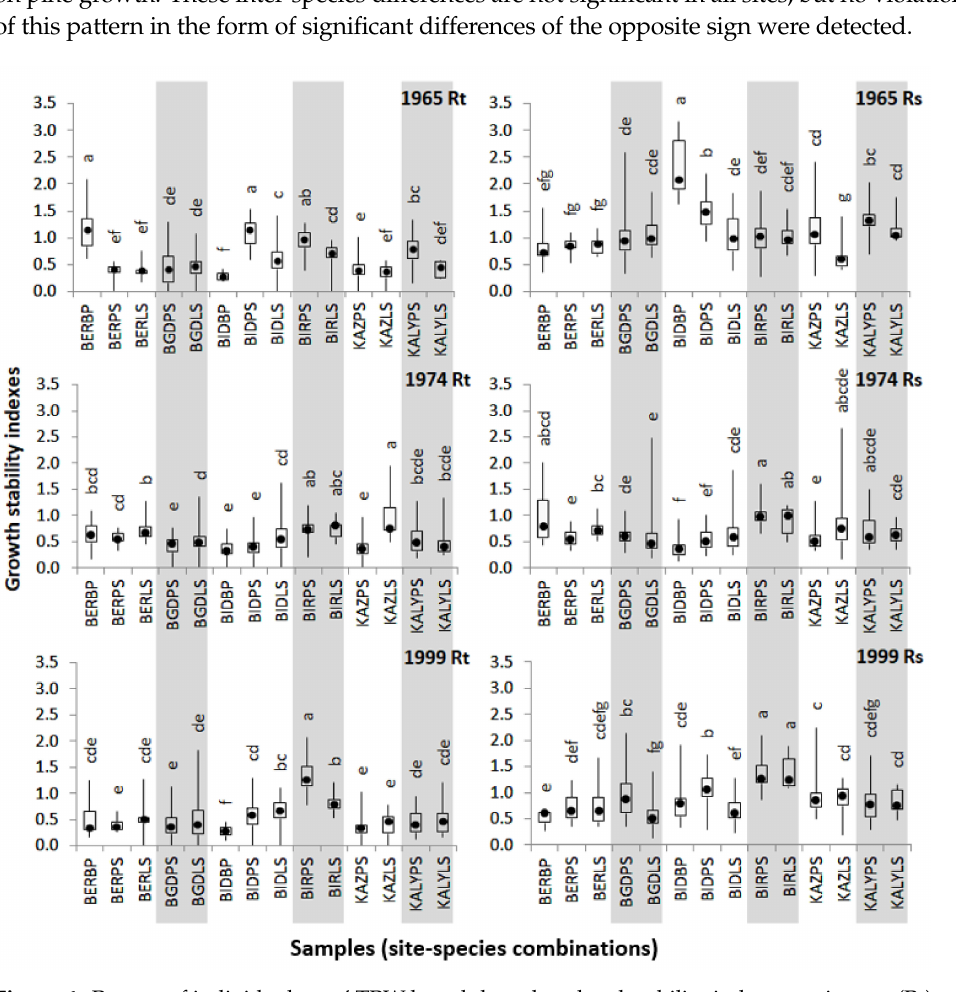
Figure 4. Ranges of individual trees’ TRW-based drought-related stability indexes, resistance (Rt) and resilience (Rs), for the studied sites (BGD, BID, KAZ, BER, BIR, and KALY) and species (BP —Betula pendula Roth., PS— Pinus sylvestris L., LS— Larix sibirica Ledeb.). The alternation of grey and white backgrounds delineates the sampling sites. On the box plots, mid-point—median value, box—inter-quartile range 25%–75%, whiskers—range of variation min–max . Comparison of site-species combinations was performed using ANOVA. Samples not marked by the same letter are different at p <